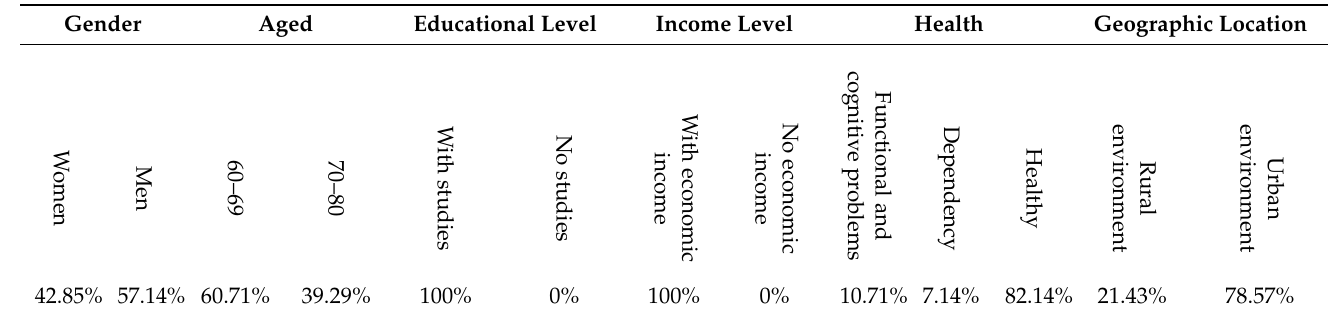
Table 1. Description of participants.